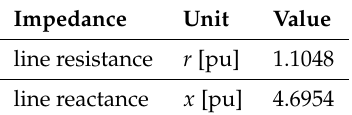
Table 2. Transmission line admittance.